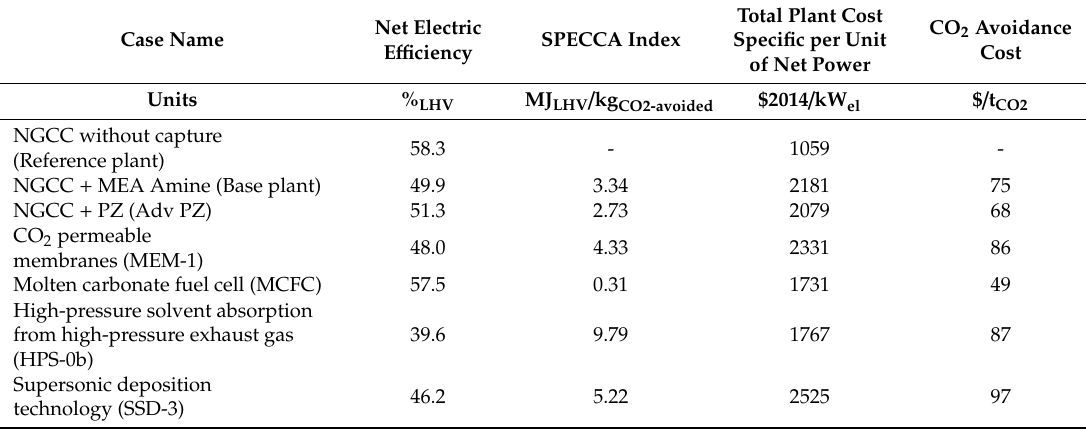
Table 23. Summary table of performance and costs of the CCS technologies